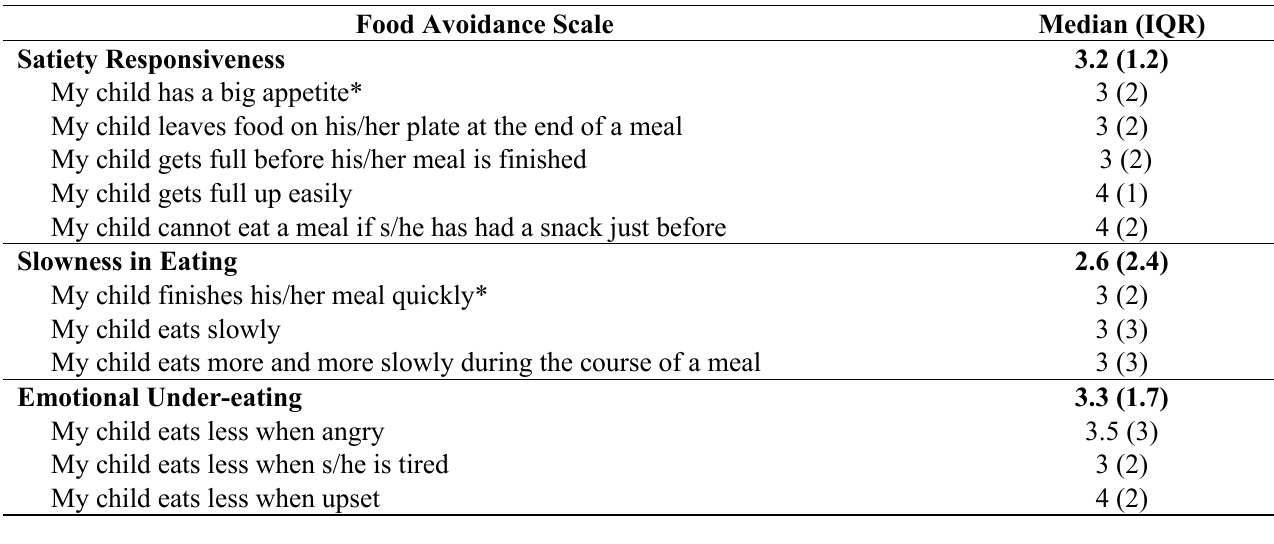
Table 2 . Distribution of food avoidance behaviour score among the subjects (N=168) Food Avoidance